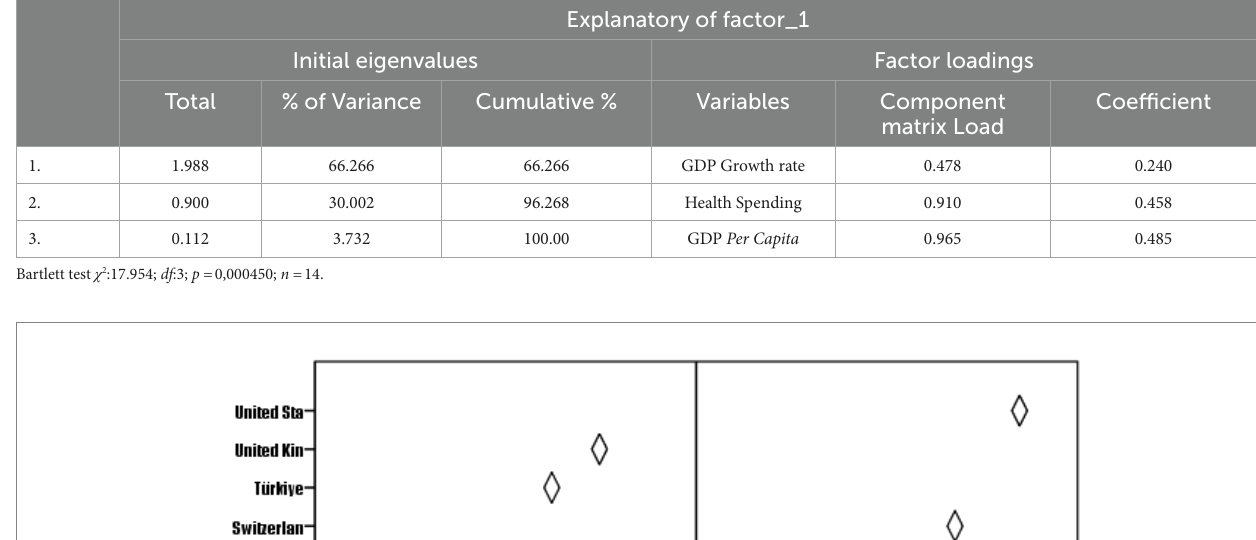
TABLE 2 Factor analysis of GDP annual growth rate, GDP per capita ($), and Health Spending per capita ($) variables.